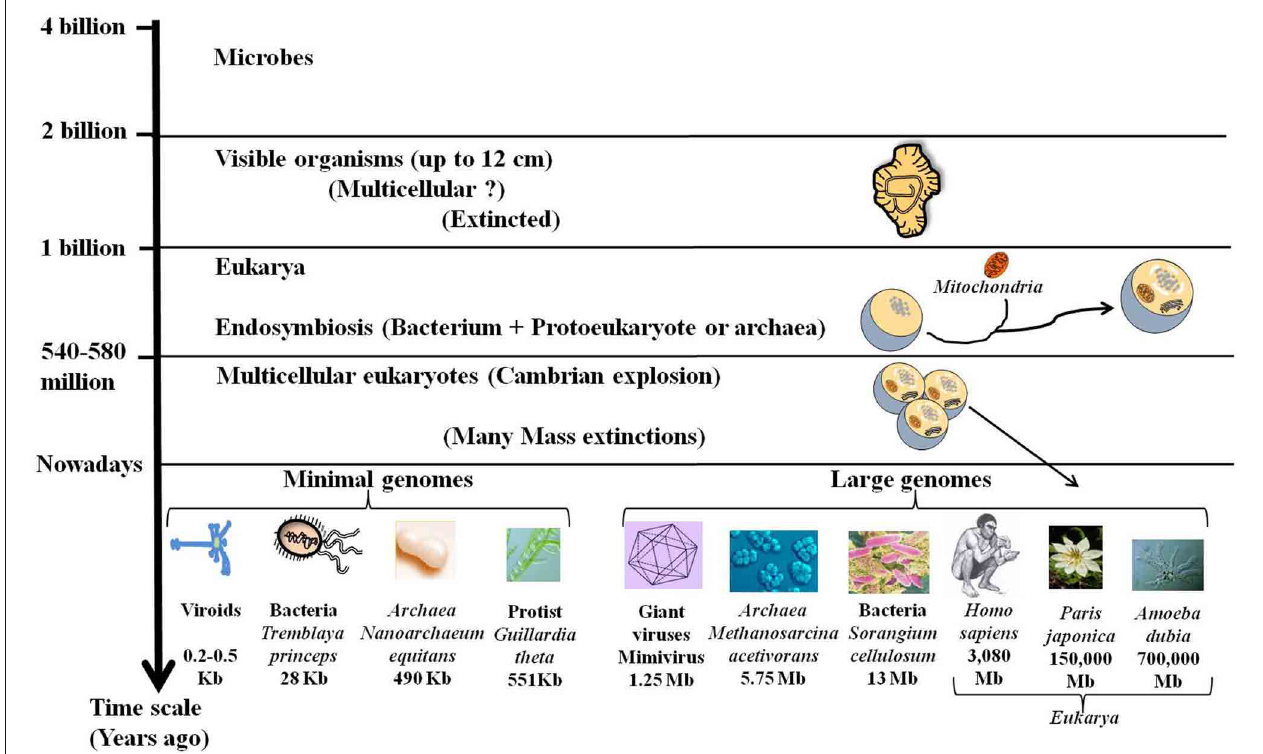
FIGURE 2 | Fossils, genome size, and complexity. Stratified evolution as deduced from fossils discoveries is characterized by the apparition and extinction of many organisms. Nowadays some complex organisms have disappeared while others are still present. These complex organisms with